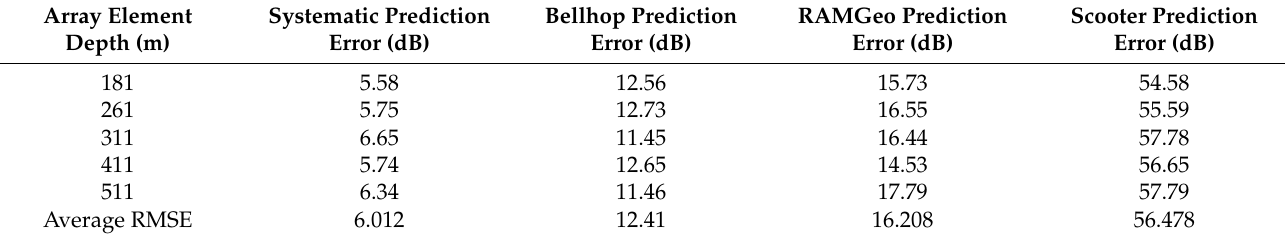
Table 7. RMSE error comparison (220–270 Hz).